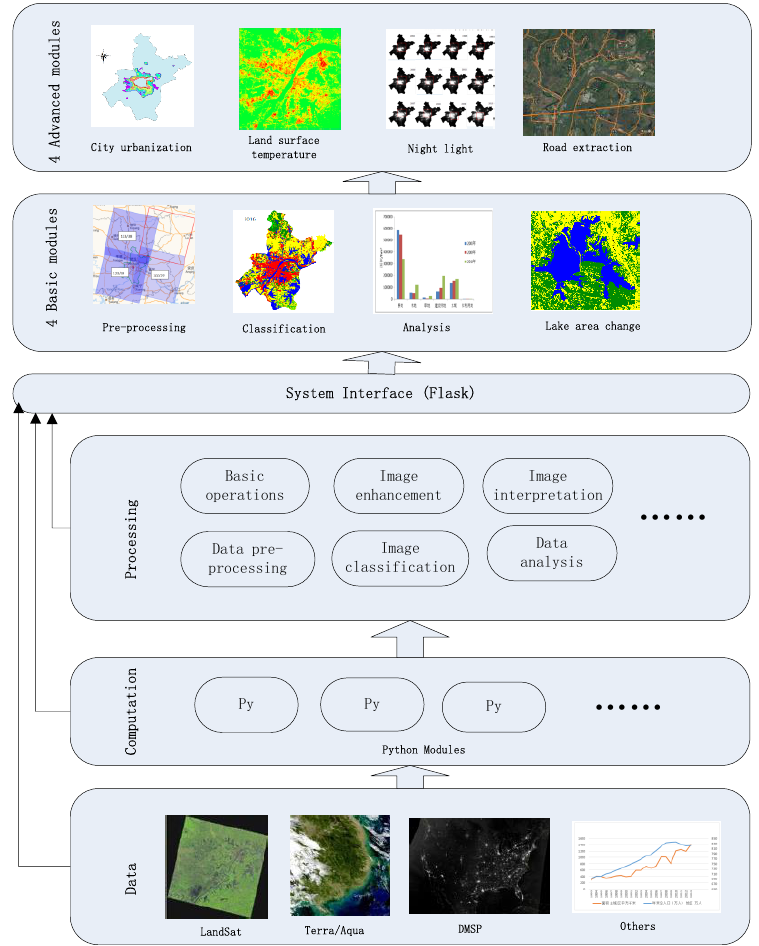
Figure 1. Architecture of the learning